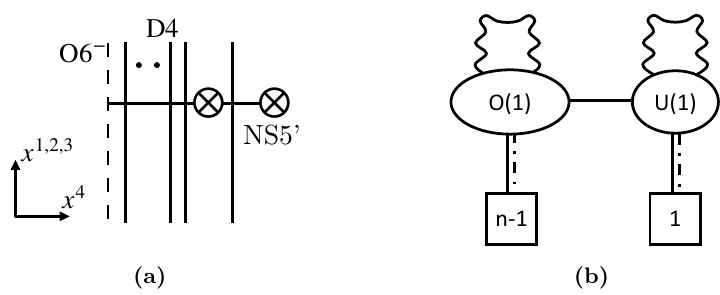
Figure 25. (a): the brane configuration for the monopole screening sector v = ± e i of T V · T V in the N = 2 ∗ USp(2 n ) gauge theory. (b): the corresponding quiver